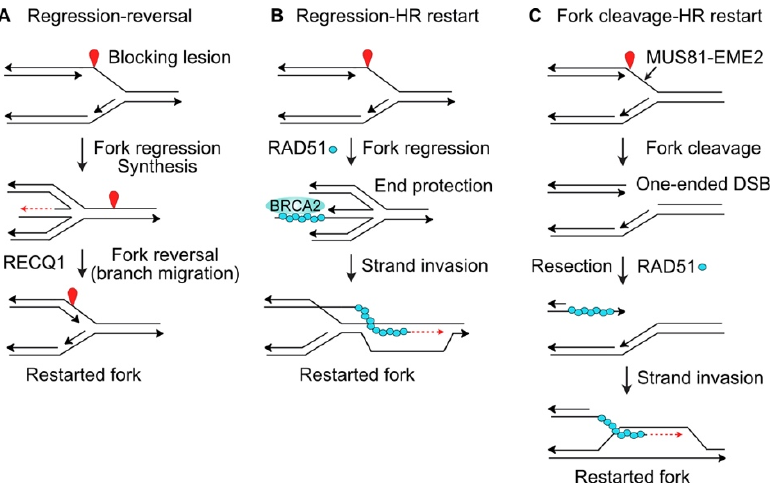
Figure 2. Fork restart mechanisms. ( A ) Blocked forks may regress to form 4-strand, Holliday junction-like structure and a one-ended DSB. DNA synthesis (dashed/red arrow) using newly replicated strand as template allows the blocked end to extend beyond the blocking lesion. The fork is restarted once RECQ1 drives fork reversal by branch migration. ( B ) The one-ended DSB at regressed forks may be protected by RAD51, BRCA2, and other factors. Fork restart is mediated by RAD51-ssDNA filament invasion of the unreplicated duplex DNA. ( C ) Stalled forks may be cleaved by MUS81-EME2 (or EEPD1, not shown), creating a one-ended DSB. Resection creates ssDNA that is first bound by RPA and then RAD51, and the RAD51-ssDNA filament catalyzes strand invasion to restart the fork, similar to panel ( B ).